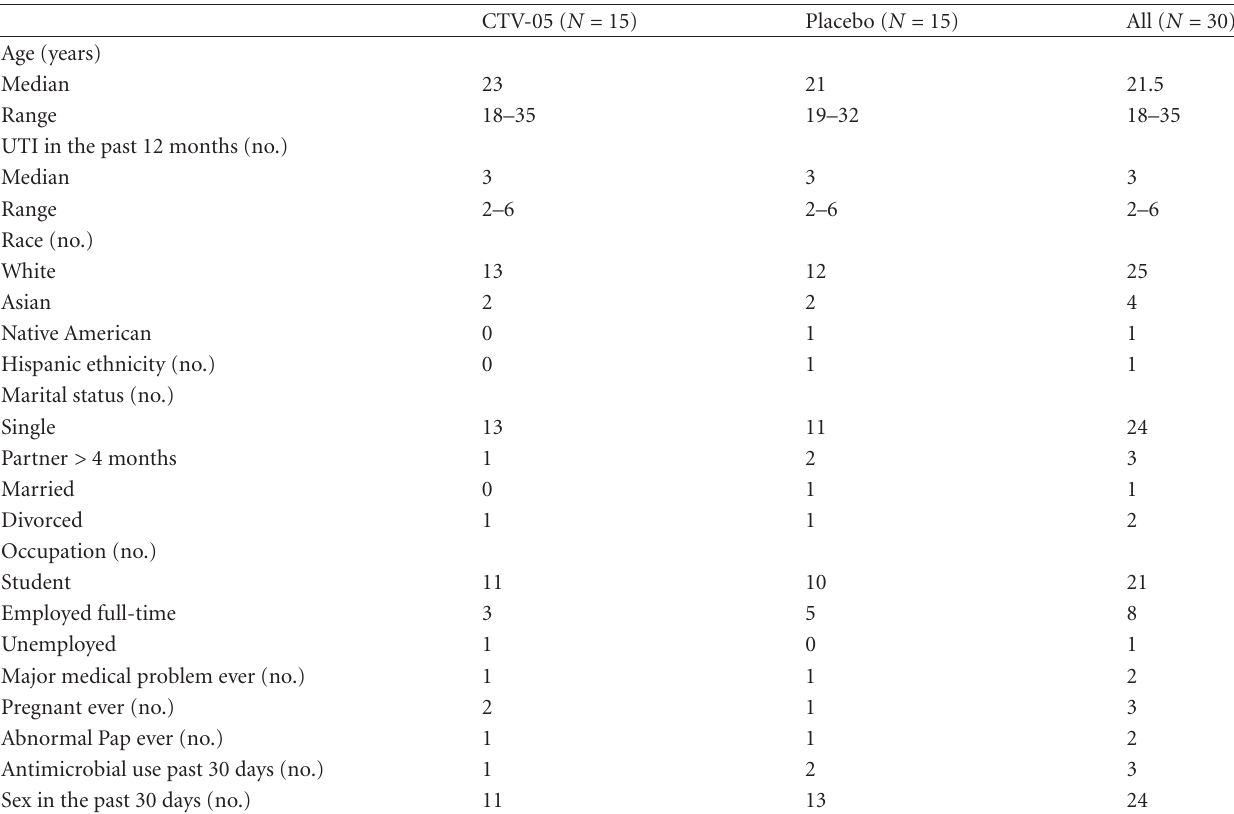
Figure 1: Randomization and followup of subjects. Table 1: Baseline characteristics of study